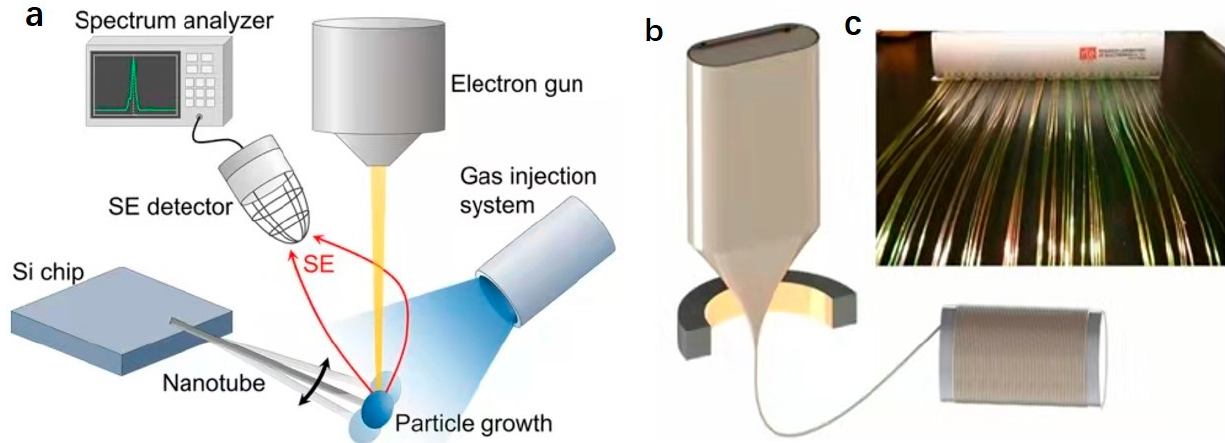
Figure 3. In-situ manufacturing and testing system of resonator and stretching process to manufacture MEMS resonator. ( a ) Schematic of particle deposition and in-situ measurement in a scanning electron microscope. Adapted with permission from [34]. ( b ) Schematic of the preform to fiber drawing process. Adapted with permission from [31]. ( c ) Flexible electrostrictive fiber array displays color reflection through the Bragg effect. Adapted with permission from [31].